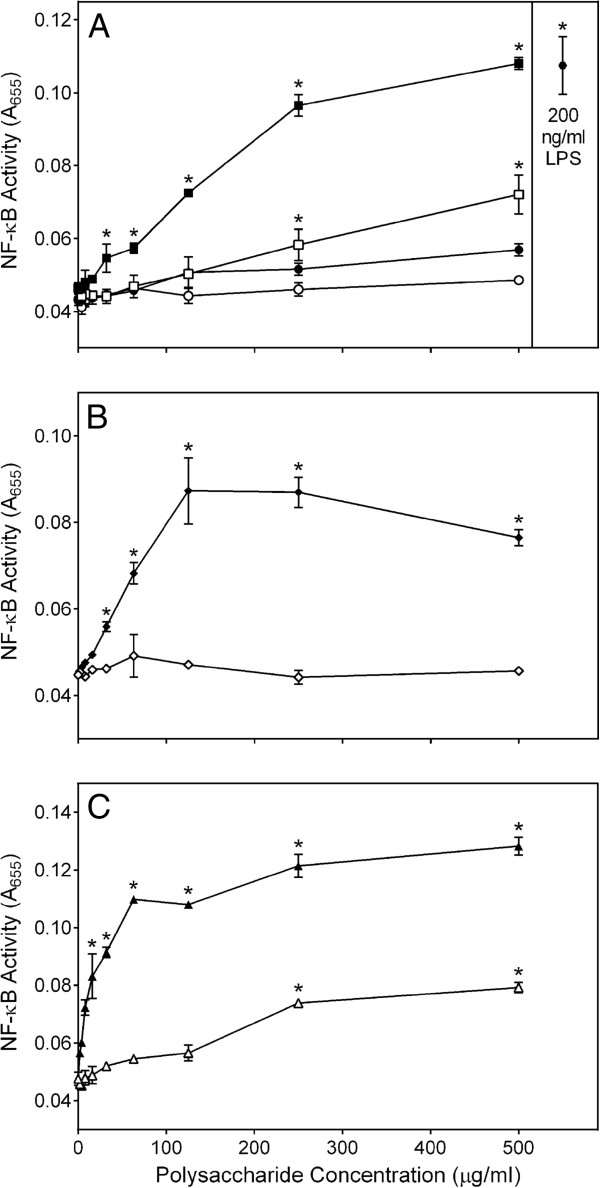
Effect of Clerodendrum polysaccharide fractions on AP-1/NF-κB activation. Human THP-1Blue monocytes were incubated for 24 hr with the indicated concentrations of CSP-NU (■, panel A), CSP-AU (□, panel A), CSP-NB (●, panel A), CSP-AB (○, panel A), CSP-AU1 (♦, panel B), CSP-AU2 (◊, panel B), CSP-NU1 (▲, panel C), CSP-NU2 (∆, panel C), or 200 ng/ml LPS (, panel A). Alkaline phosphatase activity was analyzed spectrophotometrically (absorbance at 655 nm) in the cell supernatants, as described. Values are the mean ± S.D. of triplicate samples from one experiment, which is representative of two independent experiments. Statistically significant differences (* p<0.05) between PBS-treated cells and cells treated with polysaccharide fractions or LPS are indicated.